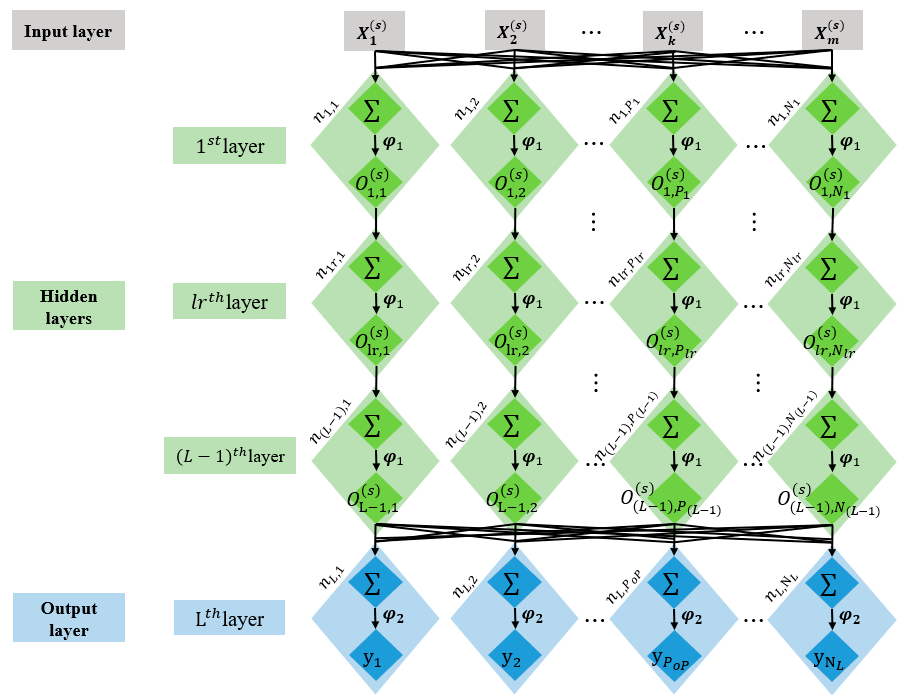
Figure 3. Structure of the ANN (Artificial Neural Network) model.